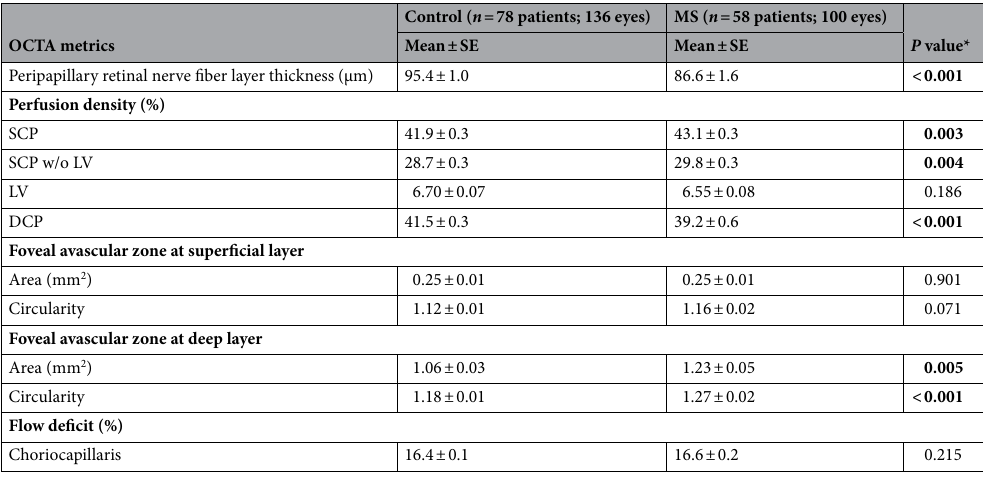
Table 3. Multivariate analysis of optical coherence tomography angiography parameters with MS. DCP deep capillary plexus , LV large vessels, OCTA optical coherence tomography angiography, SCP superficial capillary plexus, SE standard error. Significant values are in bold. *Adjusted for age, gender, hypertension, signal strength of OCT or OCTA scans, and intraocular